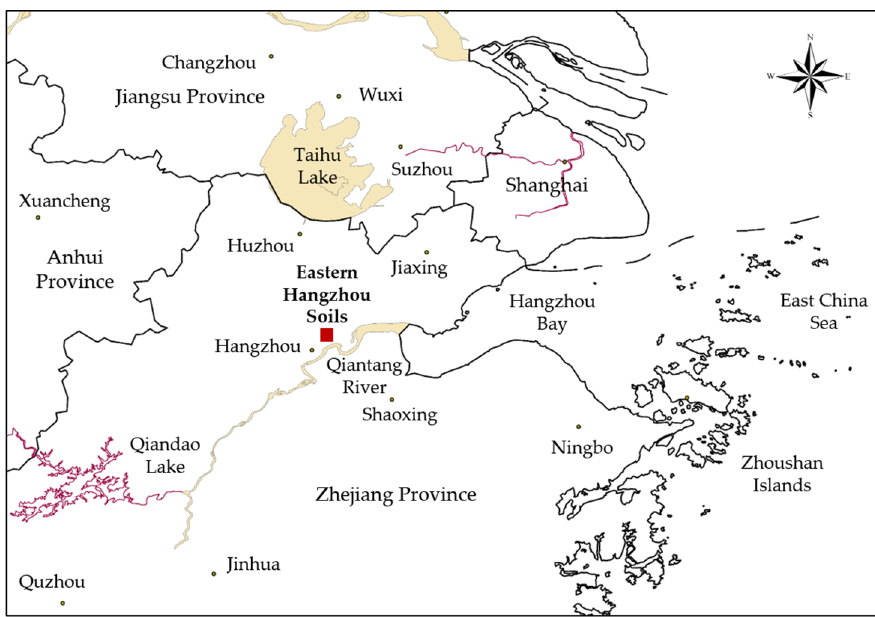
Figure 1. Unloading affected area of foundation pit excavation.